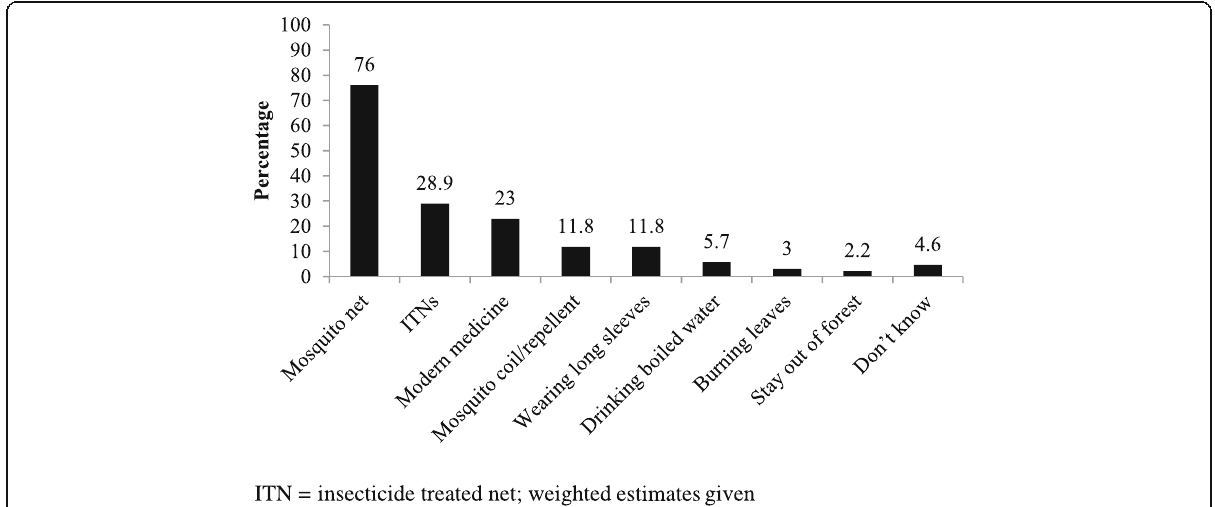
Fig. 3 Awareness about prevention of malaria among the general population in the endemic regions of Myanmar in 2015